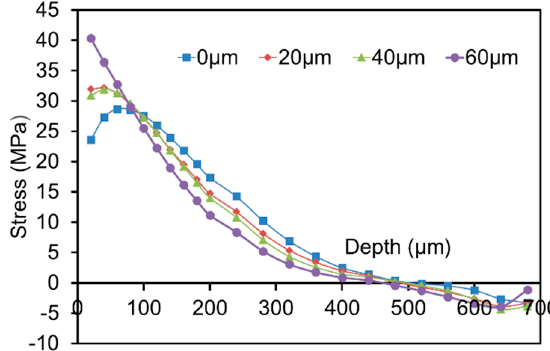
Figure 10. The effect of ill-defined depth setting on the calculated residual stresses. The values given for the various curves highlight the offset considered.